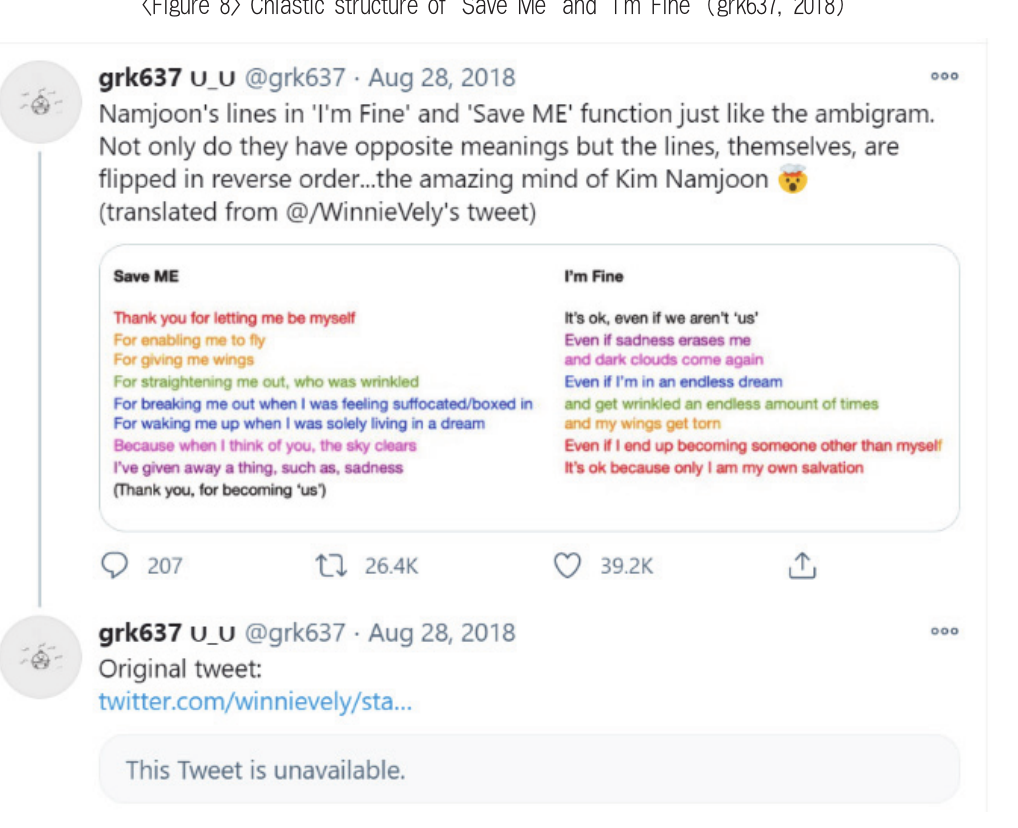
<Figure 8> Chiastic structure of “Save Me” and “I’m Fine” (grk637,